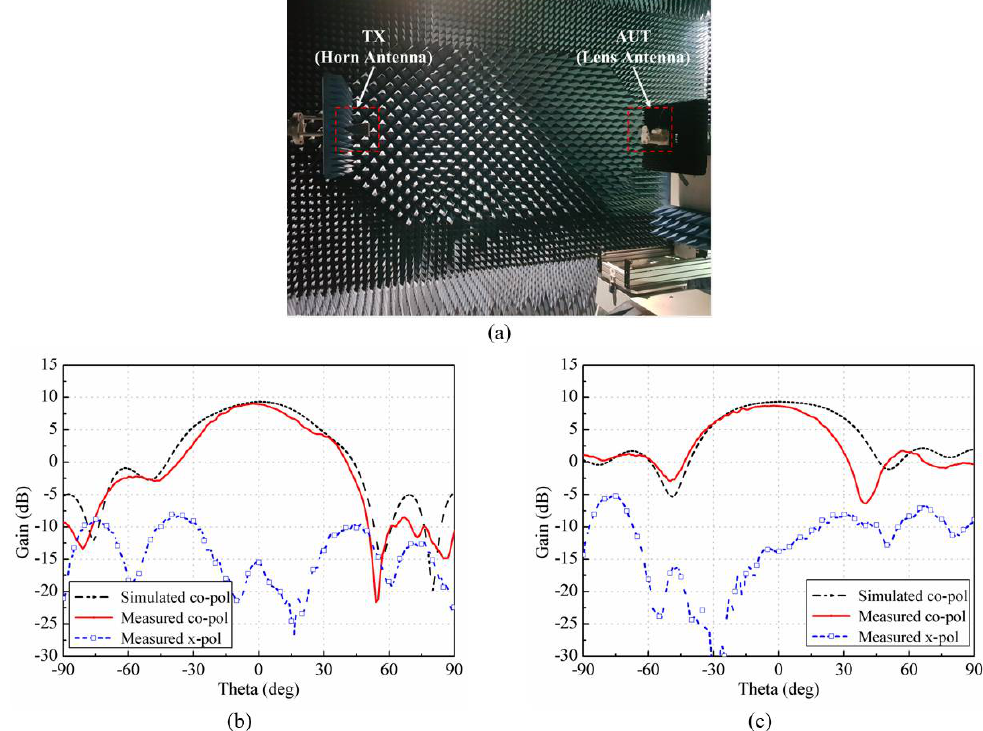
Figure 8. ( a ) Far-field radiation pattern measurement setup; simulated and measured radiation pattern for Yagi antenna at 28 GHz in ( b ) E-plane and ( c ) H-plane.